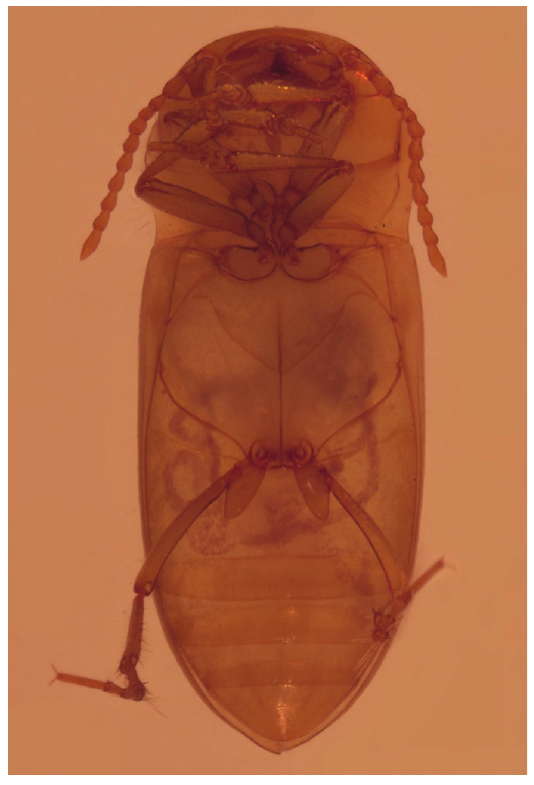
Figure 4. Iberoporus pluto sp. n., holotype, ventral view (previous to DNA extraction).